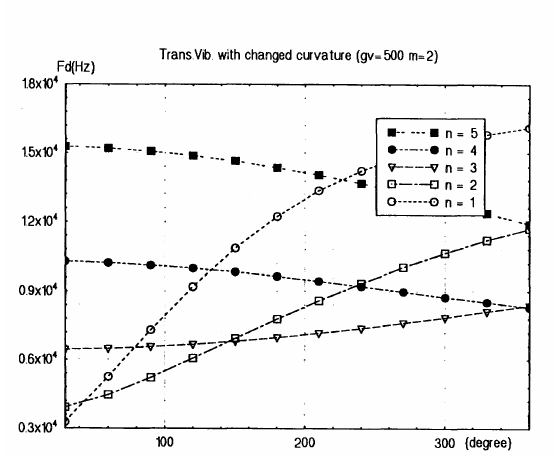
FIGURE 10 Variations of damped natural frequen cies, the (m = 2, n = 1-5) modes.